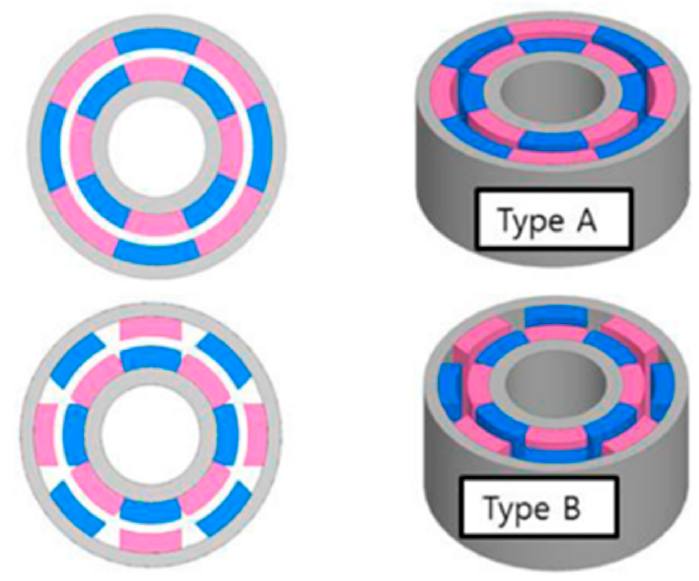
Figure 3. Three-dimensional (3D) models of Type A and Type B arrangement of magnets. Table 2. Summary of the Magnetic Coupling Configurations.